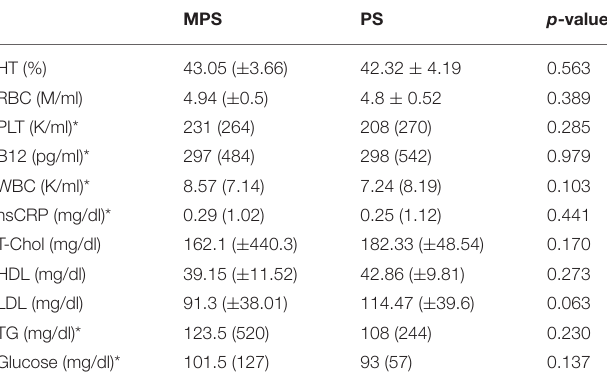
TABLE 2 | Biochemical parameters between MPS and PS.